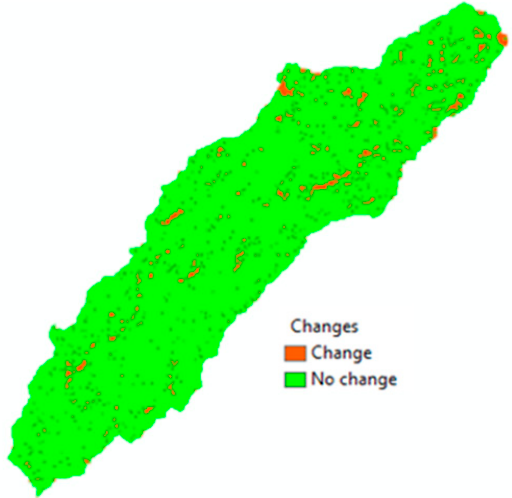
Figure 3. Changes between observed maps of 2009 and 1986.